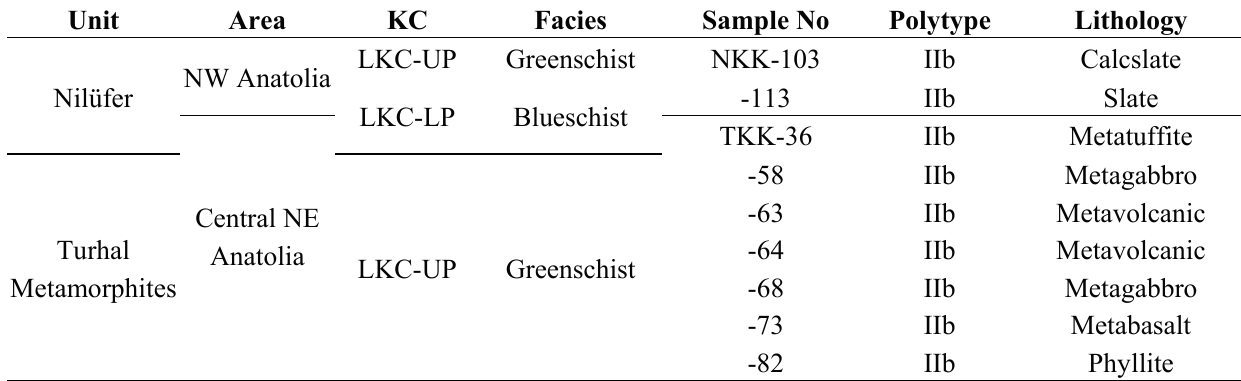
Table 2. The results of polytype examination of chlorite minerals in the Karakaya Complex units.